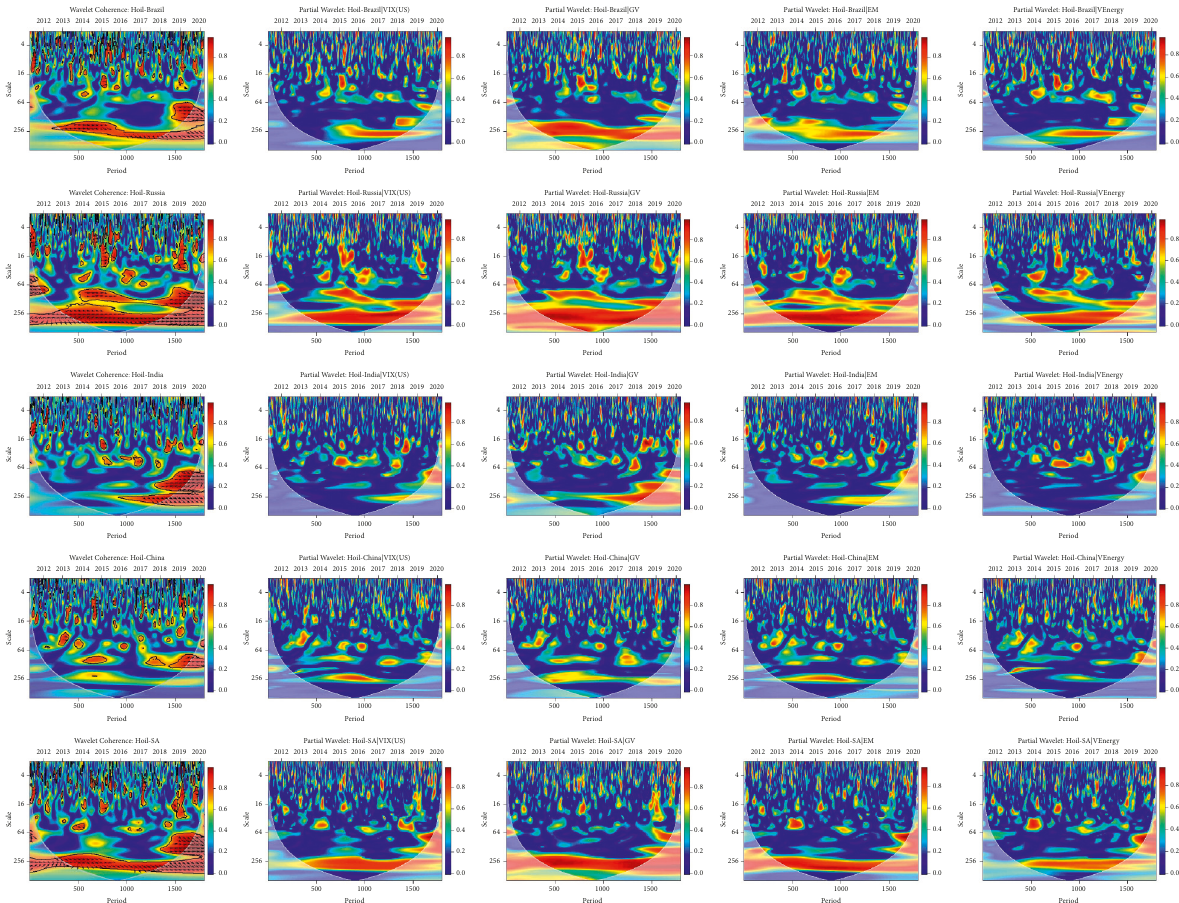
Figure 4: Comovements among heating oil, BRICS, and volatility